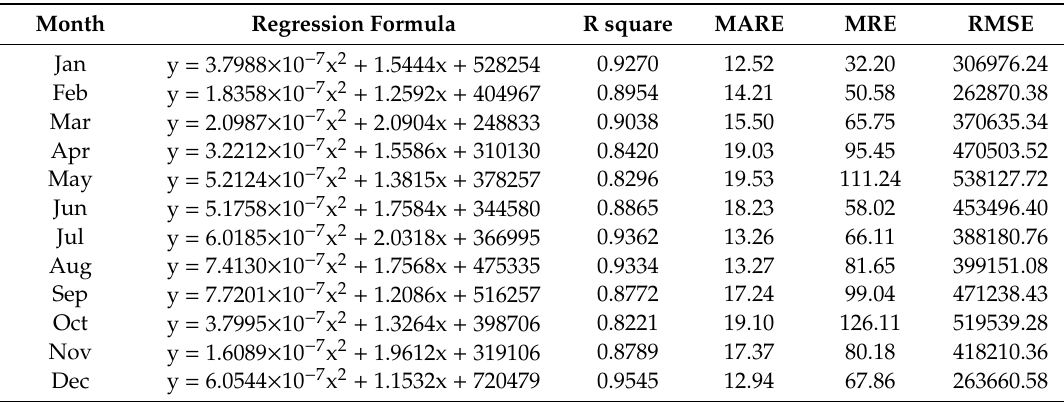
Table 2. Polynomial regression between NTL 1 and EPC for each month